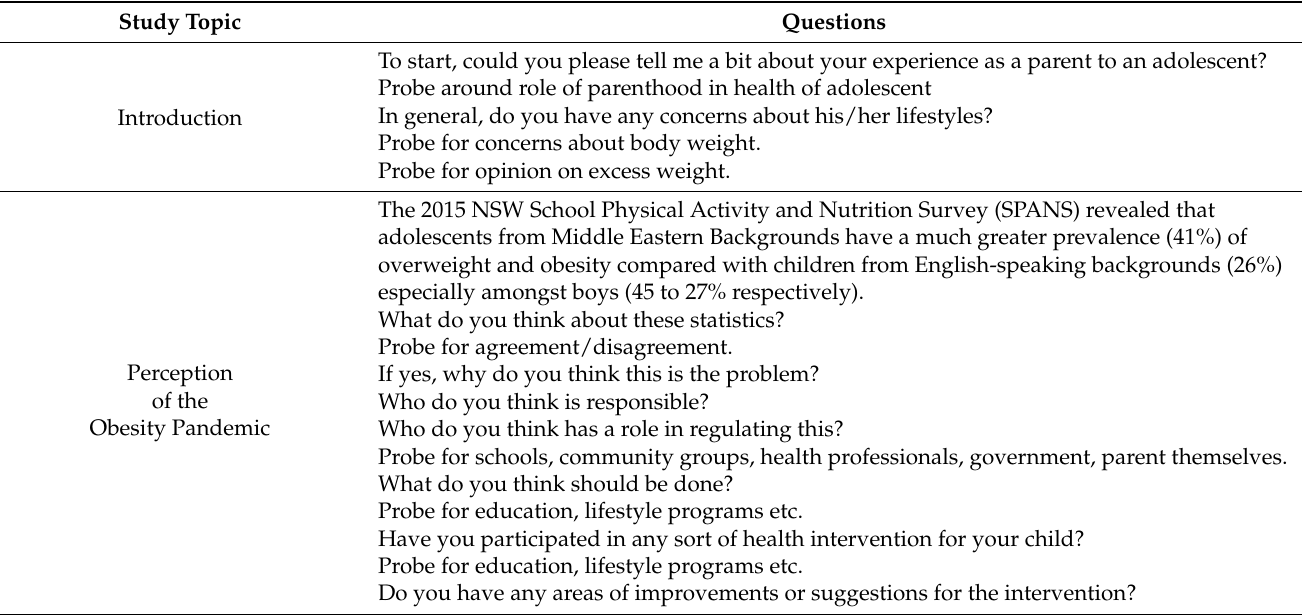
Table 1. Questions used in interviews to gather information on the capabilities, opportunities, and motivations of parents on adolescent food behavior and perception of the obesity